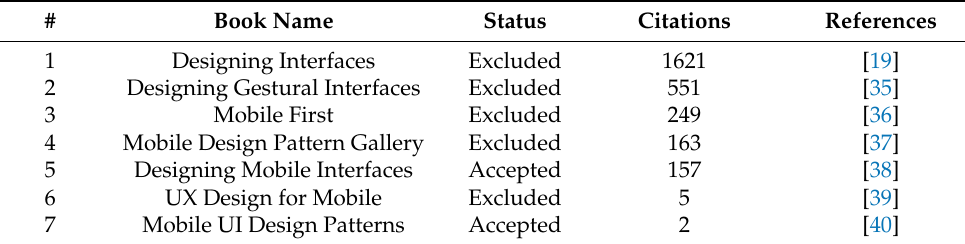
Table 4. Analyzed books.